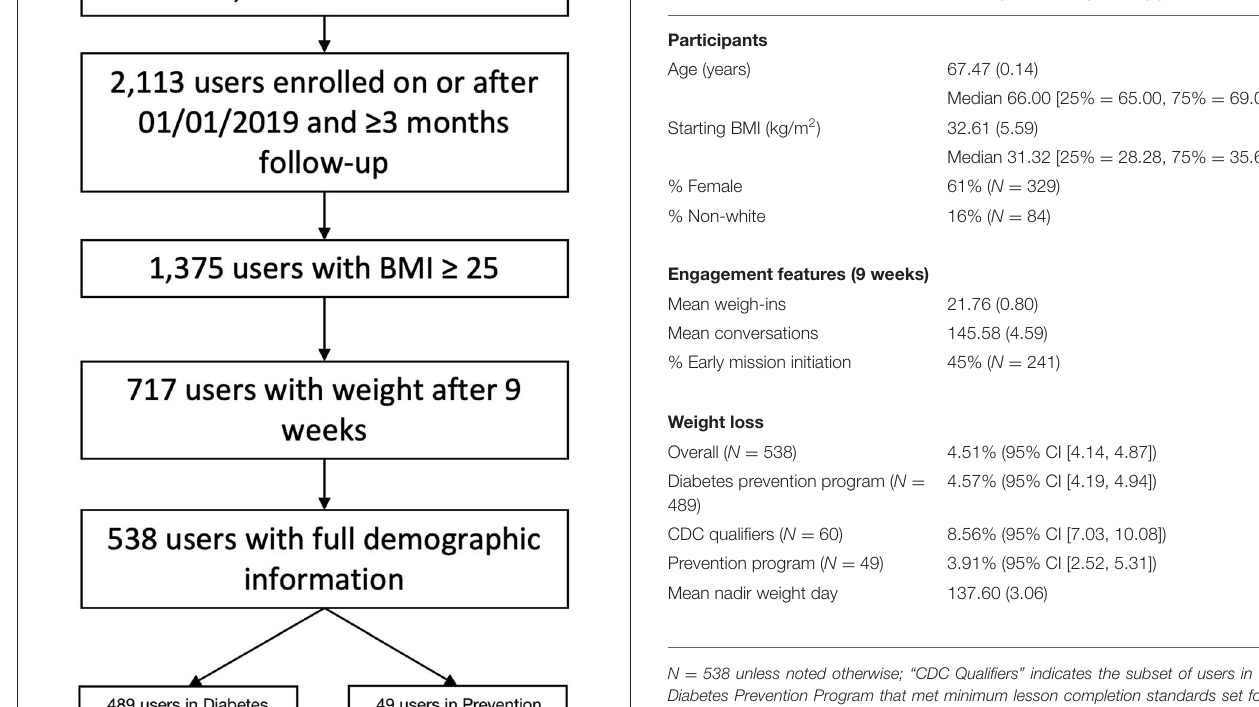
(SD = 3.28). More than half of users were female (61%), and 16% were non-white. Mean Body Mass Index (BMI) was 32.61 kg/m 2 (SD = 5.59) (see Table 1 for complete demographics and characteristics).